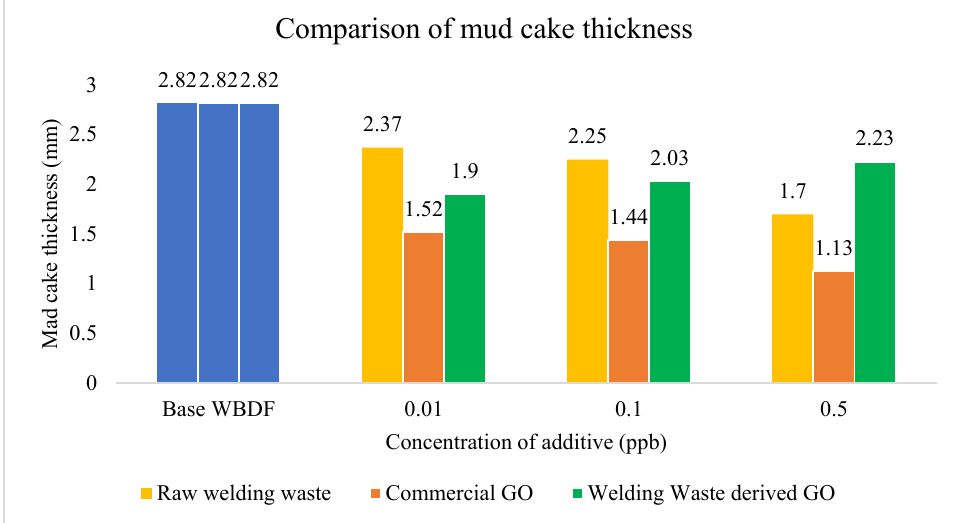
Figure 11. MCT comparison of WBDF using different additives.